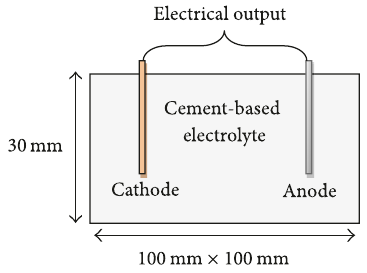
Figure 4: Basic schematic of the battery with cement-based elec-